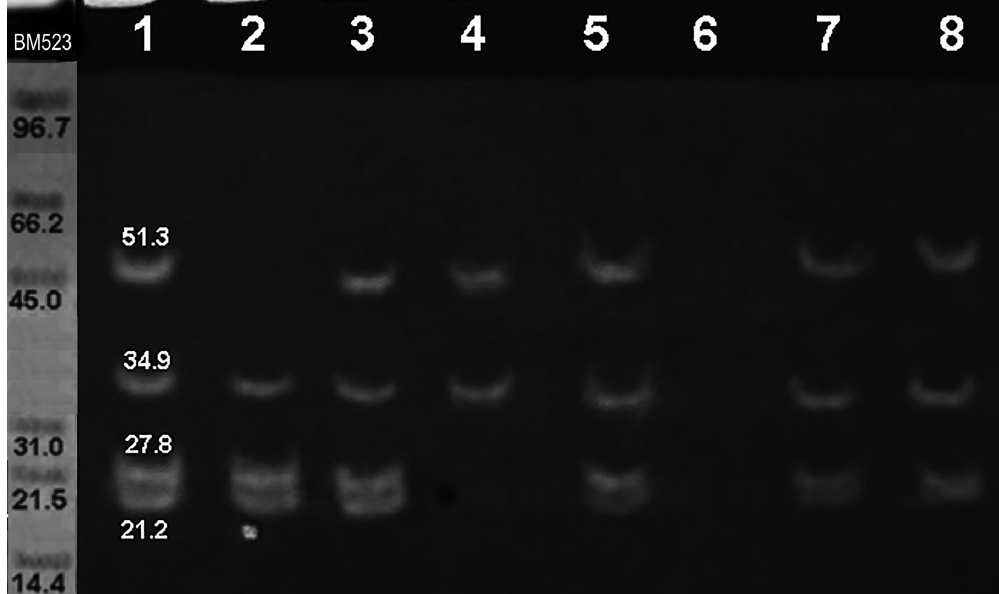
Fig. 5. SDS-PAGE electrophoresis analysis of alkaline digestive proteases of Archosargus probatocephalus : BM523 (mole- cular weight marker Bio Basic Inc; rabbit phosphorylase B 96.7 kDa, bovine serum albumin 66.2 kDa, ovalbumin 45 kDa, carbonic anhydrase 31.0 kDa soybean trypsin inhibitor 21.5 kDa and lysozyme 14.4 kDa), Control (1); inhibitors: OVO (2), PMSF (3), SBT1 (4), TPCK (5), TLCK (6), PHEN (7) and EDTA